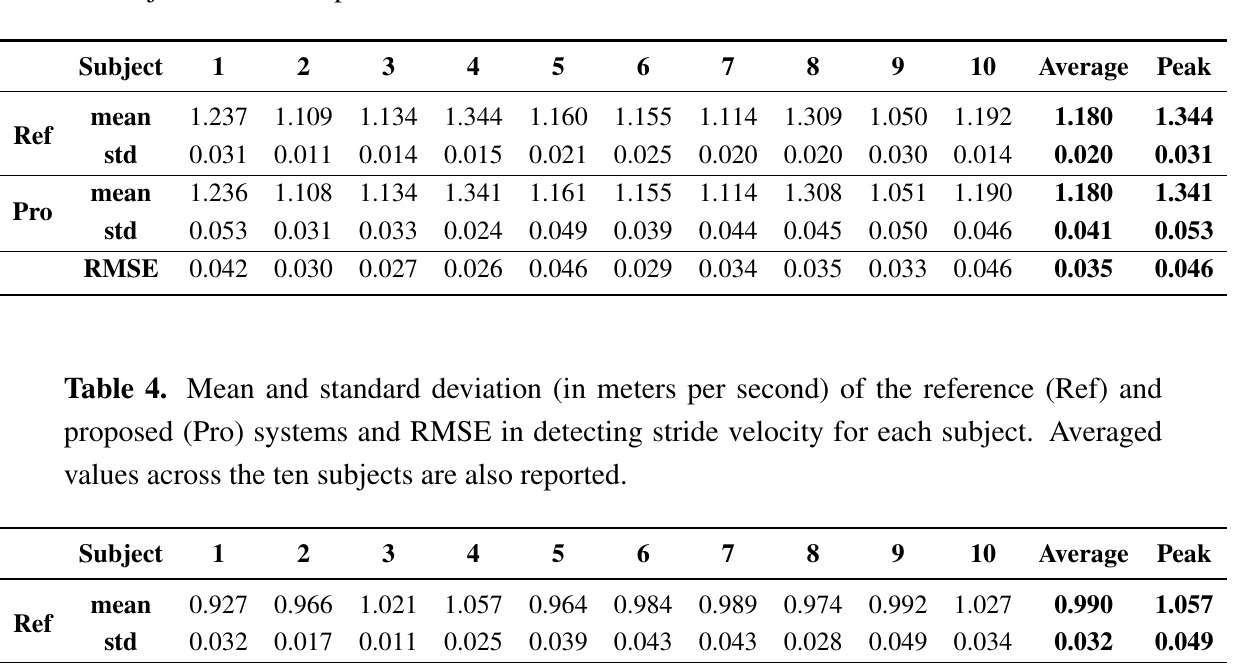
Table 3. Mean and standard deviation (in seconds) of the reference (Ref) and proposed (Pro) systems and RMSE in detecting stride duration for each subject. Averaged values across the ten subjects are also reported.